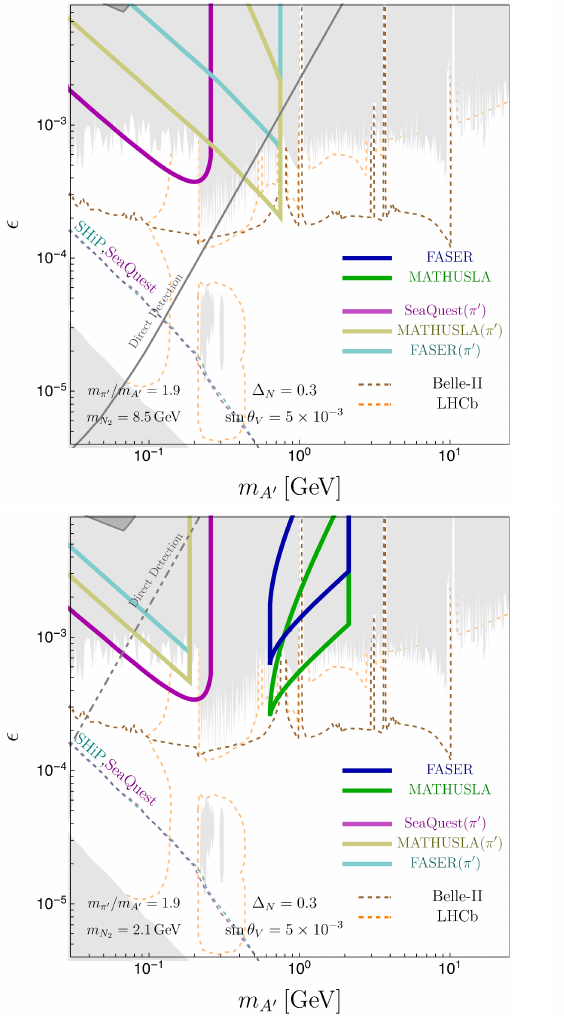
Figure 6 . Summary plots of the visible decay searches of the composite ADM model at the visible decay searches. Blue and green solid lines show the future sensitivity to the dark nucleon transition, N + f ¯ f , at the LHC lifetime frontier: MATHUSLA (green) and FASER (blue). 1 → N 2 Cyan and yellow lines show the future sensitivity to the dark pion decay, π 0 3 → A 0 + f ¯ f , at the LHC lifetime frontier, MATHUSLA (yellow) and FASER (cyan), while magenta line shows the future sensitivity to the decay at SeaQuest. The dark shaded region is excluded by E137 constraint on the dark pion decay. We take the dark nucleon mass m = 8 . 5 , 4 . 3 , 2 . 1 , 1 . 1GeV and pion decay N 2 constant f = 0 . 8 , 0 . 4 , 0 . 2 , 0 . 1 GeV . We take the dark nucleon parameters to be ∆ = 0 . 3 and π 0 N sin θ = 5 × 10 − 3 , while the dark pion mass is m = 1 . 9 in all panels. The existence constraints V π 0 /m A 0 and the future sensitivities to the visible dark photon decay (the top and left-bottom shaded areas and the future sensitivity curves from Belle-II, LHCb, SHiP, and SeaQuest) are the same as figure